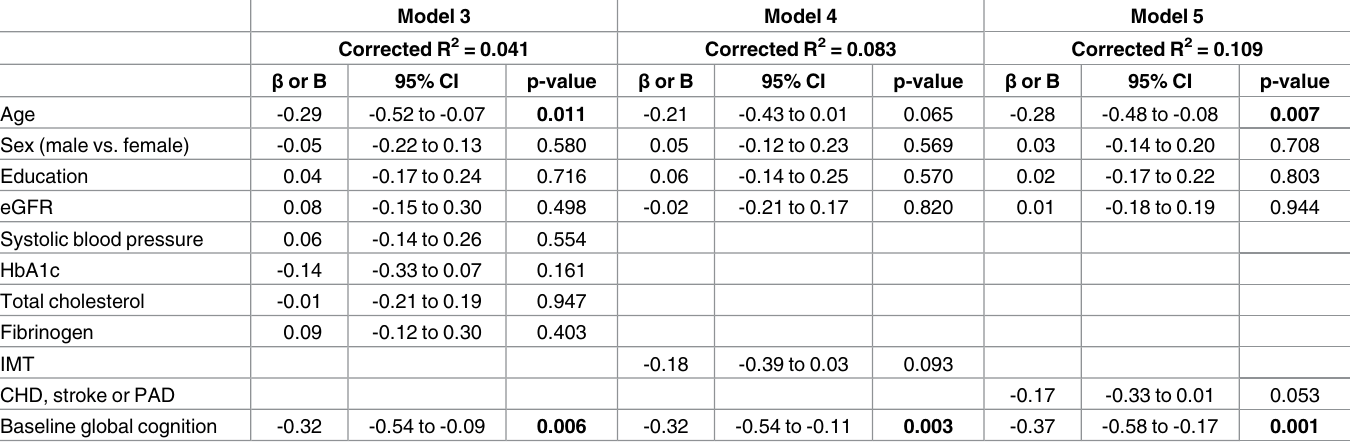
Table 5. Baseline Predictors for Change of Global Cognitive Performance from Baseline to Follow-up in the Total Cohort: More Complex Multivari- able Models.